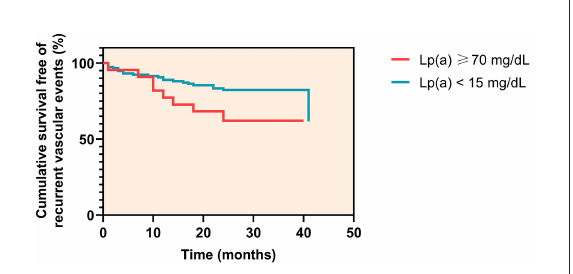
FIGURE4 Kaplan-Meier curves for cumulative survival free of recurrent vascular events.